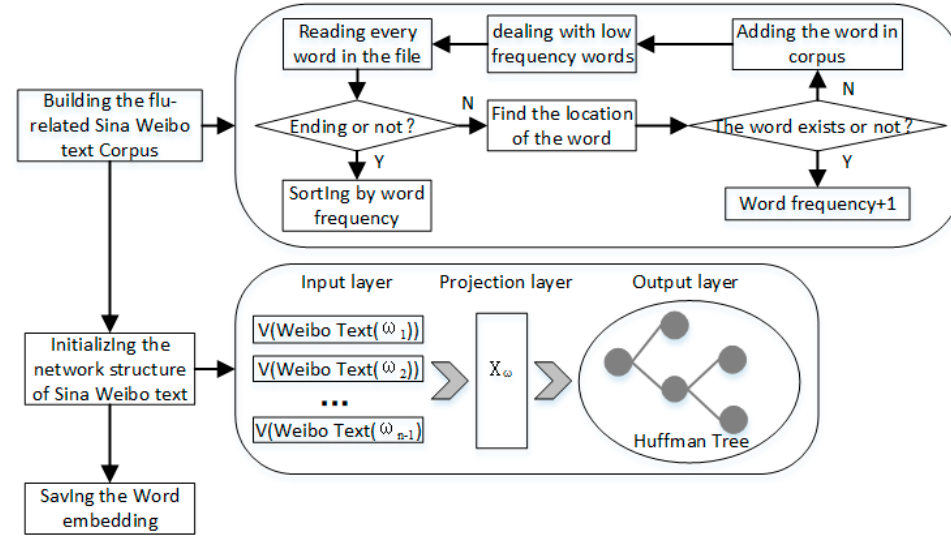
Figure 7. Word2vector Principles of Sina Weibo Text.